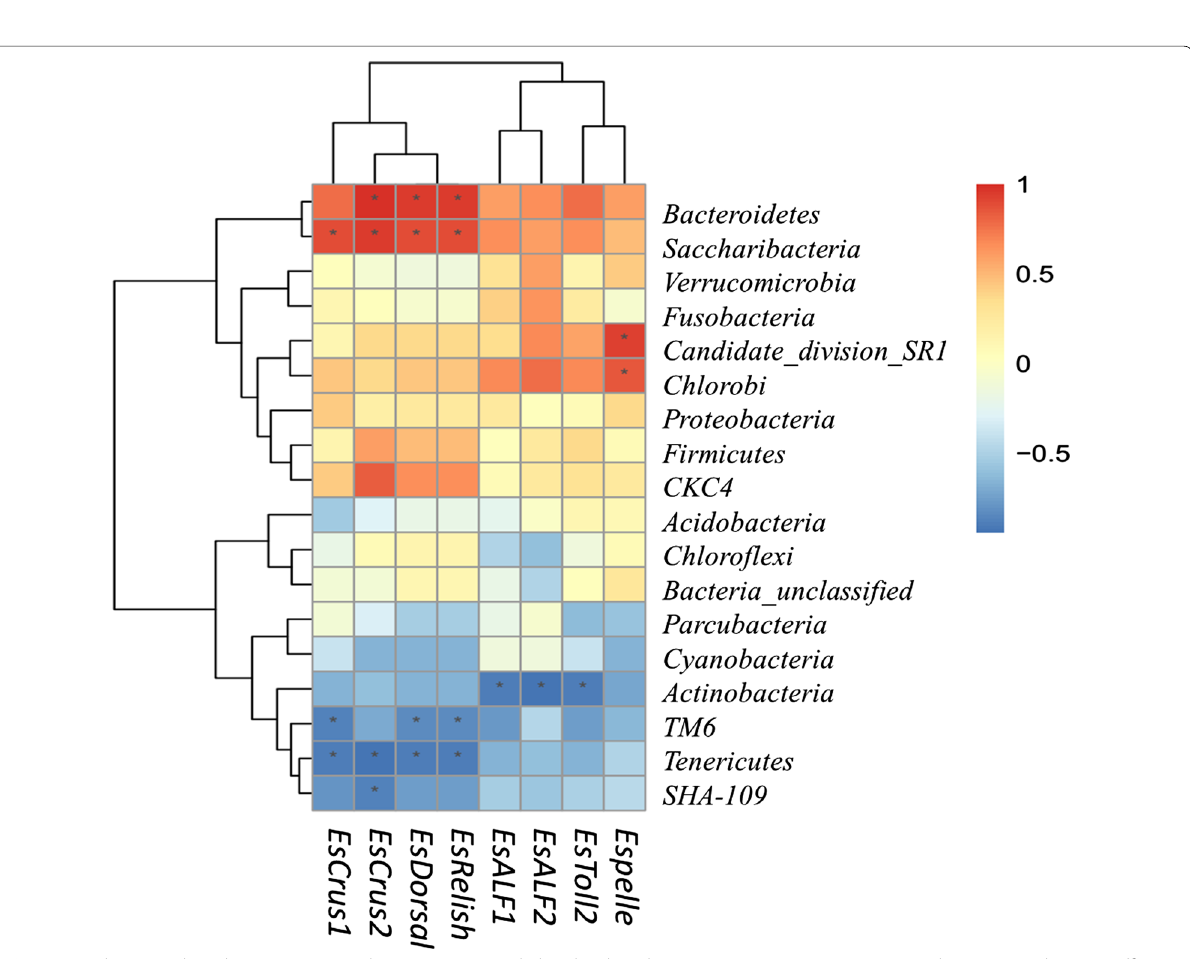
Fig. 6 Correlation analyses between intestinal microorganism (phylum level) and gut immune genes expression. R values are correlation coefficient shown in different colors in the figure, the red color represents a positive correlation, the blue color represents a negative correlation. * P <